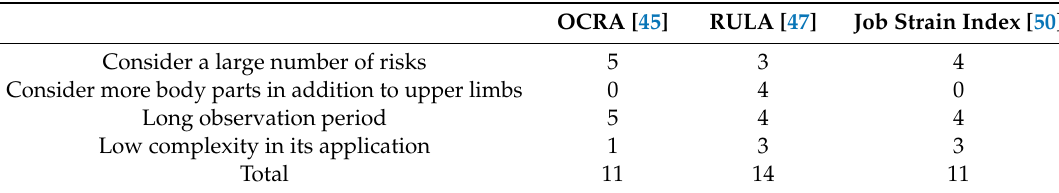
Table 1. Decision matrix for selecting the method.